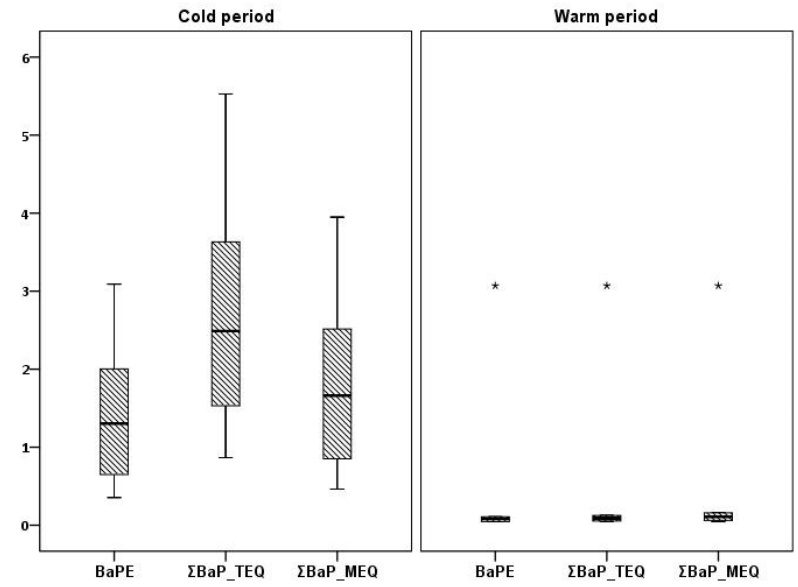
Figure 9. Seasonal variation of BaPE, Σ BaP TEQ , and Σ BaP MEQ (* outliers).